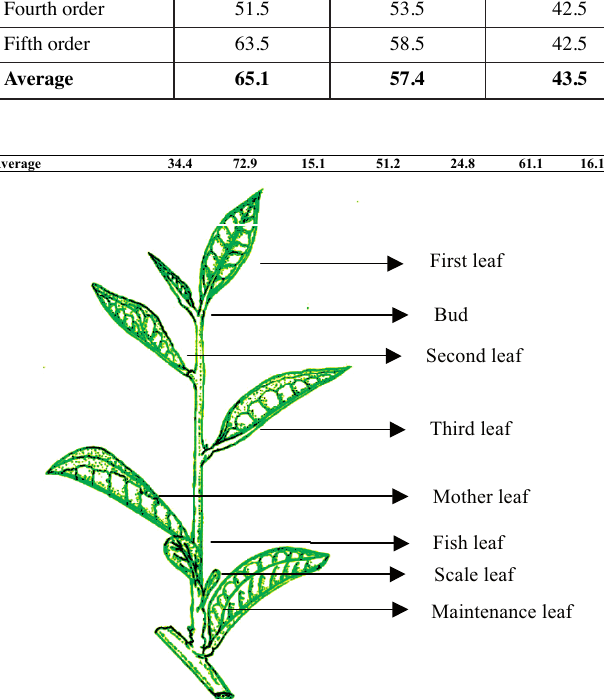
Fig. 1: Shoot structure of a periodic tea shoot containing different types of leaves leaf to scale leaf, scale leaf to fish leaf and fish leaf to mother leaf (Tab. 3). Figure 2. Branching pattern of a tea